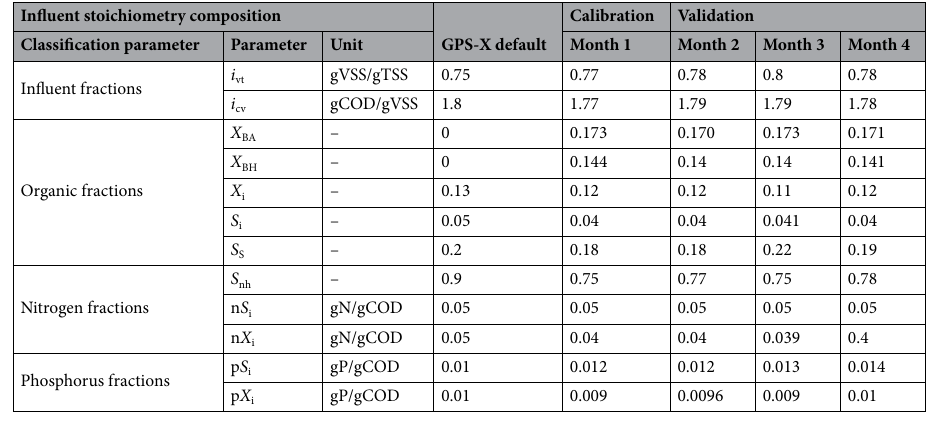
Table 6. GPS-X input stoichiometry parameters (default and adjusted) based on GPS-X influent adviser.